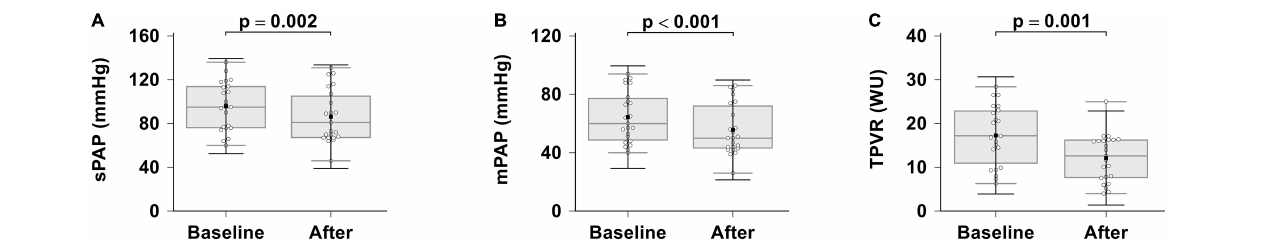
FIGURE 1 | Effects of ambrisentan plus PDE-5i combination therapy on hemodynamics. (A) sPAP; (B) mPAP; (C) TPVR. sPAP, systolic pulmonary artery pressure; mPAP, mean pulmonary artery pressure; TPVR, total pulmonary vascular resistance.